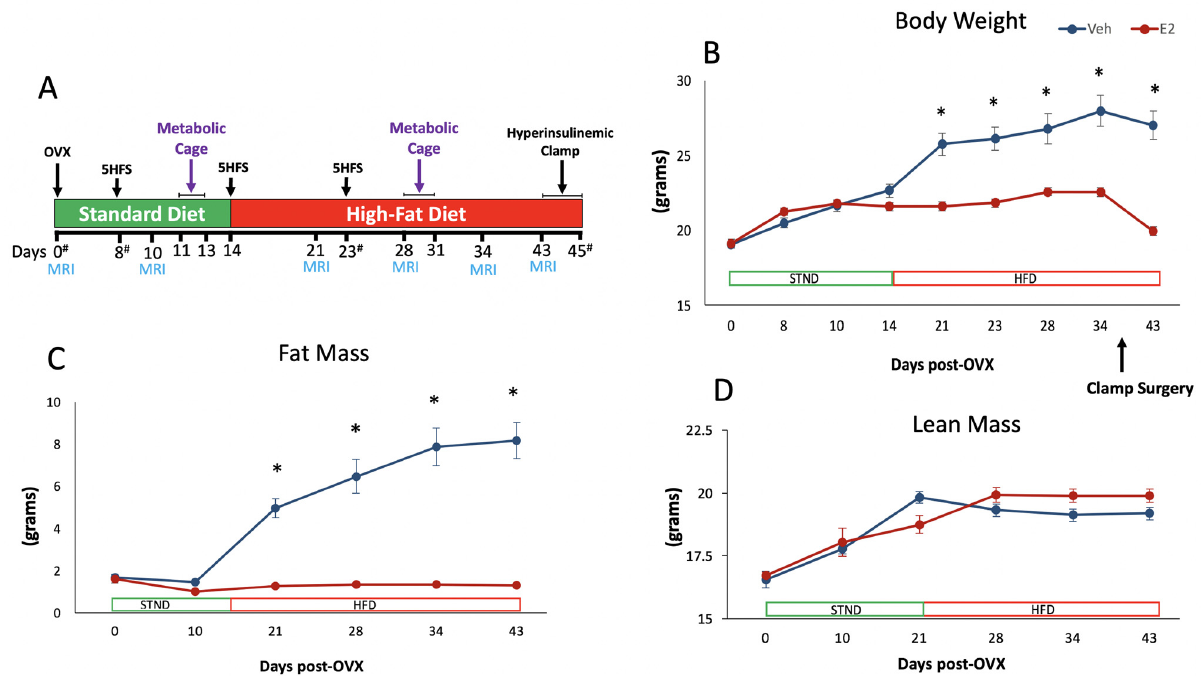
Figure 1. Estradiol attenuates weight gain in female mice on a high-fat diet (HFD). Experimental timeline ( A ). Ten-week old mice were ovariectomized and implanted with capsules containing E2 (50 µg) or Veh implants (n = 6/group). Animals were placed in metabolic cages for 3 days, once each during STND and HFD. Body weight ( B ) Fat mass ( C ) Lean mass ( D ). Mice were switched from standard diet (STND) to HFD on day 14. Surgery for the hyperinsulinemic- euglycemic clamp on days 37–39 (4 mice/day) resulted in weight change in both groups. Error bars are shown as ± SEM. * denotes p < 0.001, using repeated measures ANOVA followed by t -test. OVX: ovariectomy; 5HFS: 5-h fasting blood glucose; MRI: body composition measurement using proton magnetic resonance spectroscopy (1H-MRS); Clamp: hyperinsulinemic- euglycemic clamp; # indicates fecal sample collection days.